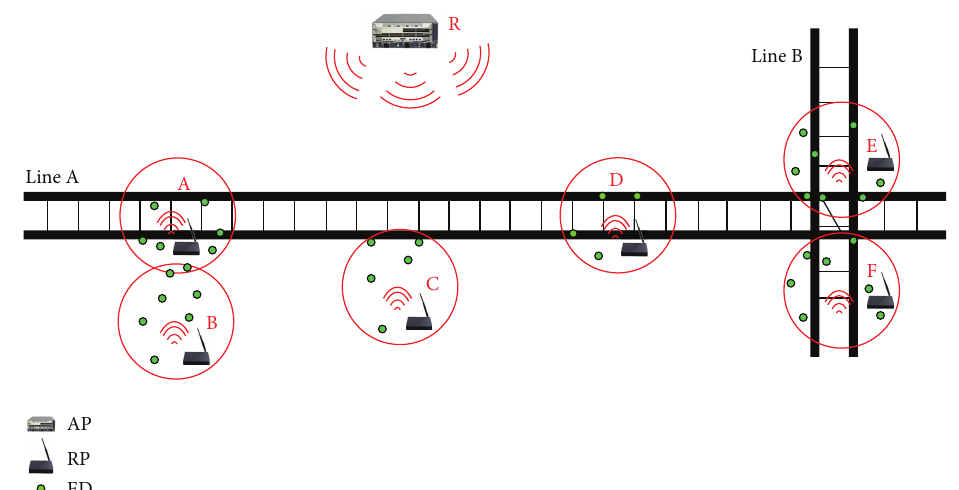
Figure 4: A practical instance for IHM of